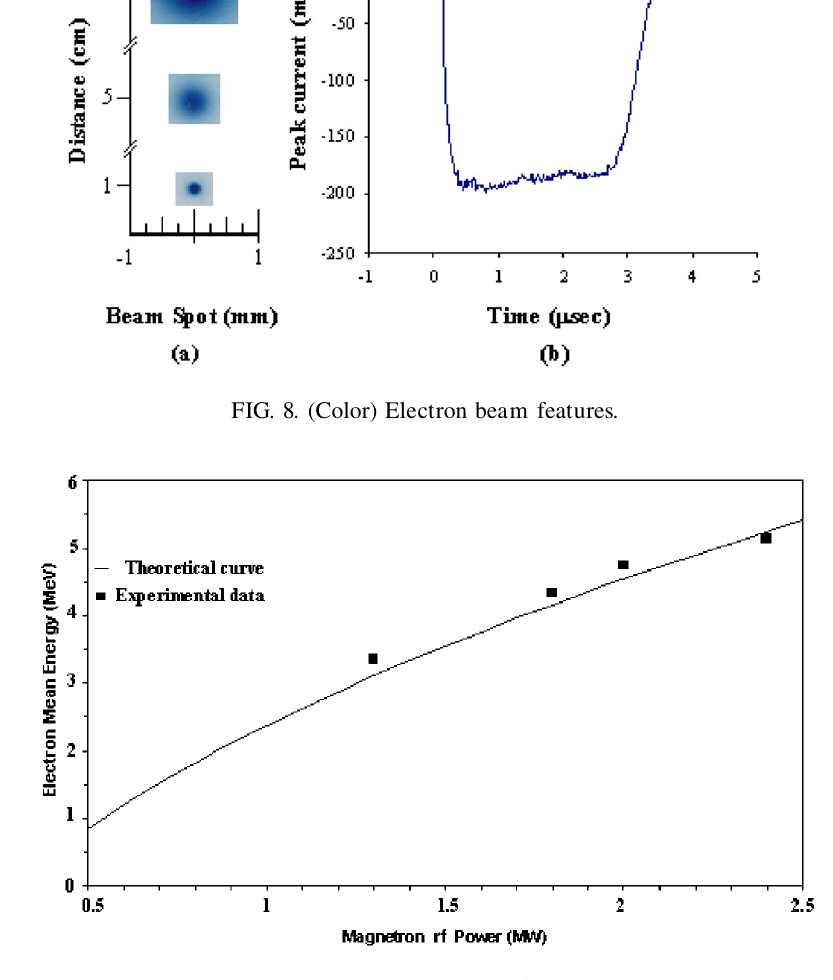
FIG. 9. Beam energy vs rf power.